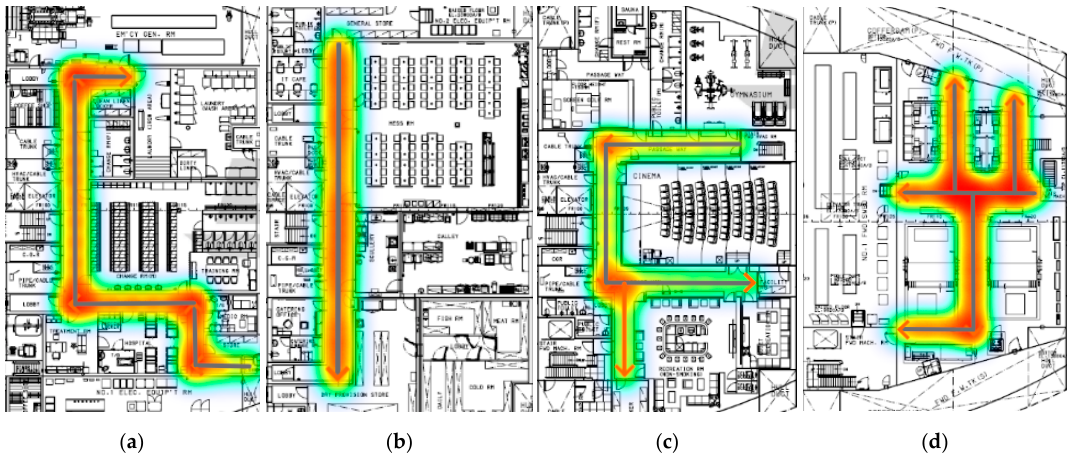
Figure 10. Collected radio maps for each deck: ( a ) main deck; ( b ) A deck; ( c ) first deck; ( d ) second deck.